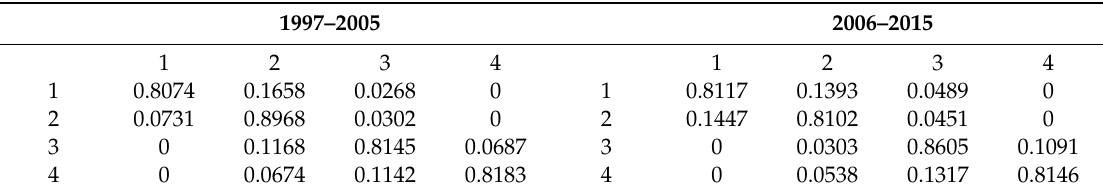
Table 2. Traditional Markov Probability Transfer Matrix of Eco-e ffi ciency of Industrial Energy in the Yangtze River Economic Belt from 1997 to